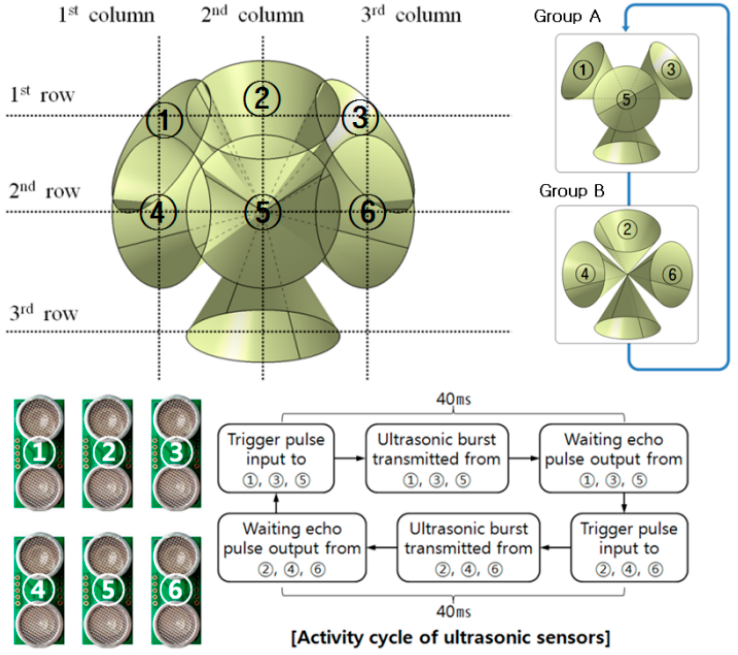
Figure 8. Processing of sensor groups and scanning area.